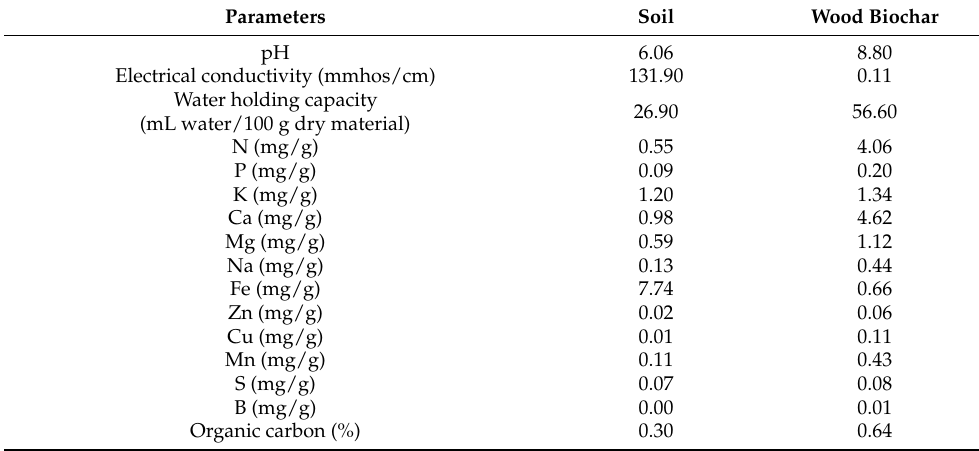
Table 1. Characteristics of soil and wood-derived biochar.